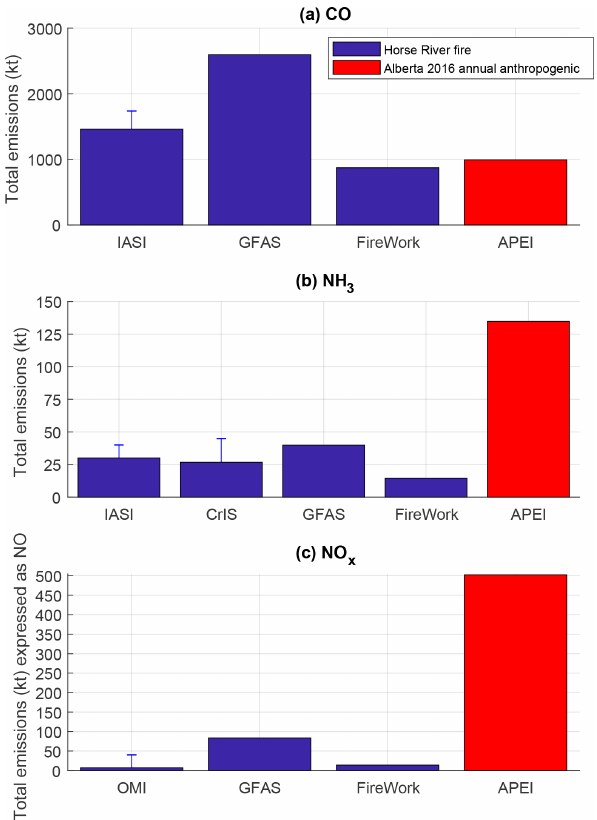
Figure 11. Total emissions for the Horse River fire in May 2016 from satellite and models (blue), with total annual anthropogenic emissions for Alberta from the 2016 APEI (red). The error bars represent satellite emissions scaled by models to account for gaps in sampling. The APEI emissions have been converted so that they are expressed as kt of